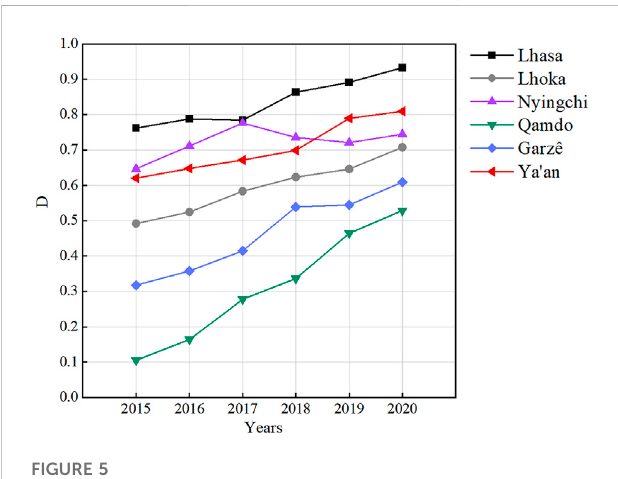
FIGURE 5 Trends in the evolution of resilience coupling